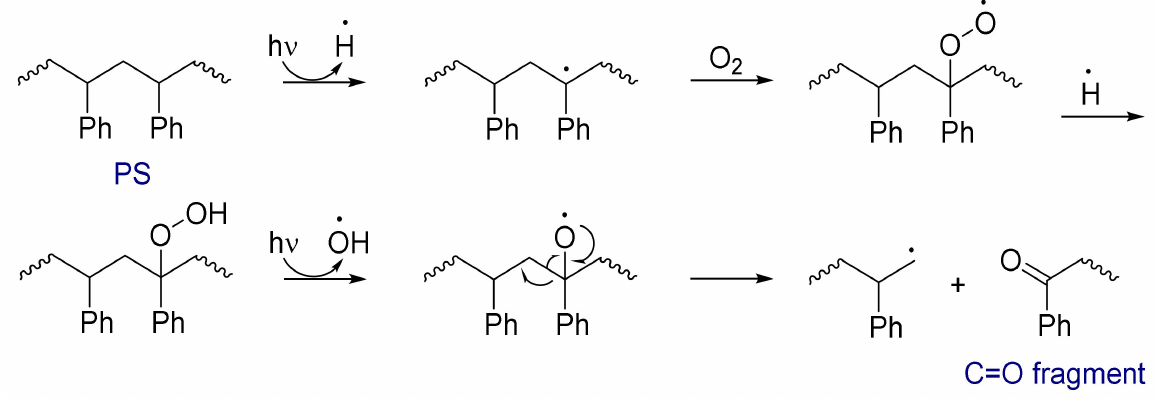
Figure 2. Photodegradation of PS in the presence of oxygen leading to formation of carbonyl group- containing